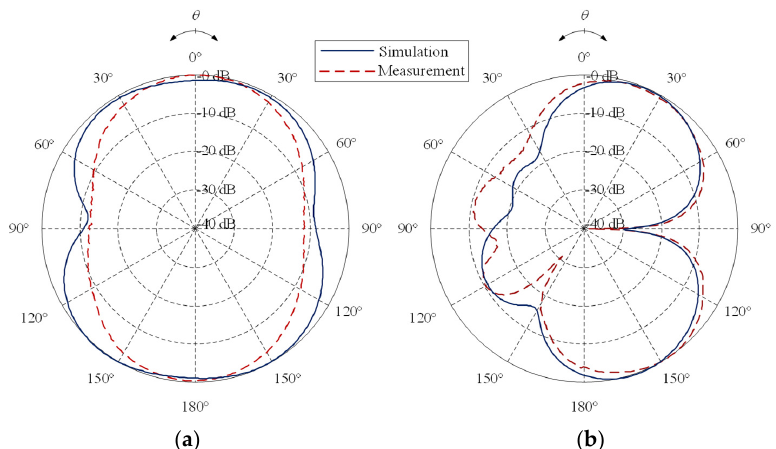
( a ) ( b ) Figure 13. Simulated and measured radiation pattern at 15.5 GHz: ( a ) xz -plane and ( b ) yz -plane.